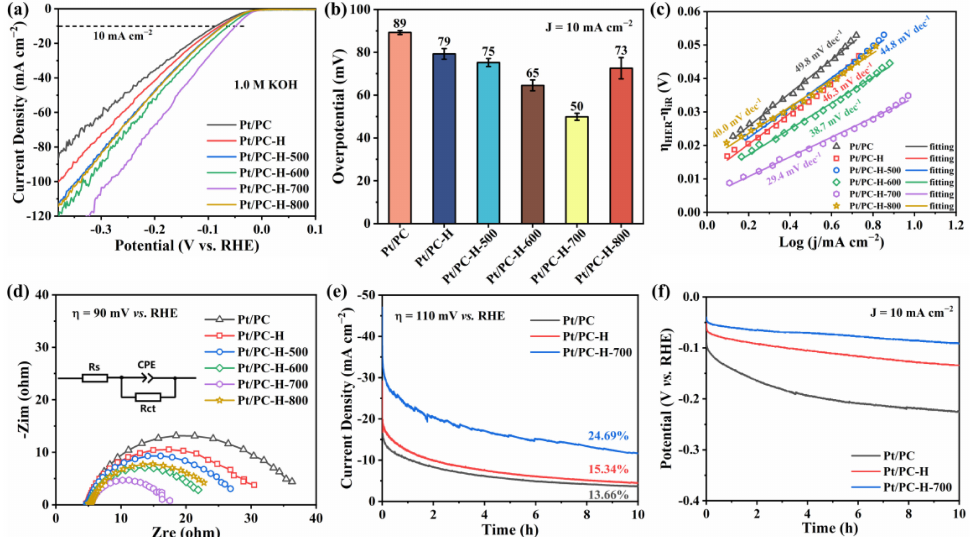
Figure 7. ( a ) LSV curves, ( b ) overpotential at 10 mA cm − 2 , ( c ) Tafel slope values, and ( d ) EIS plots (inset shows the equivalent circuit model) of Pt/PC, Pt/PC-H, Pt/PC-H-500, Pt/PC-H-600, Pt/PC-H-700, and Pt/PC-H-800 catalysts. I-t ( e ) and V-t ( f ) curves of Pt/PC, Pt/PC-H, and Pt/PC-H- 700